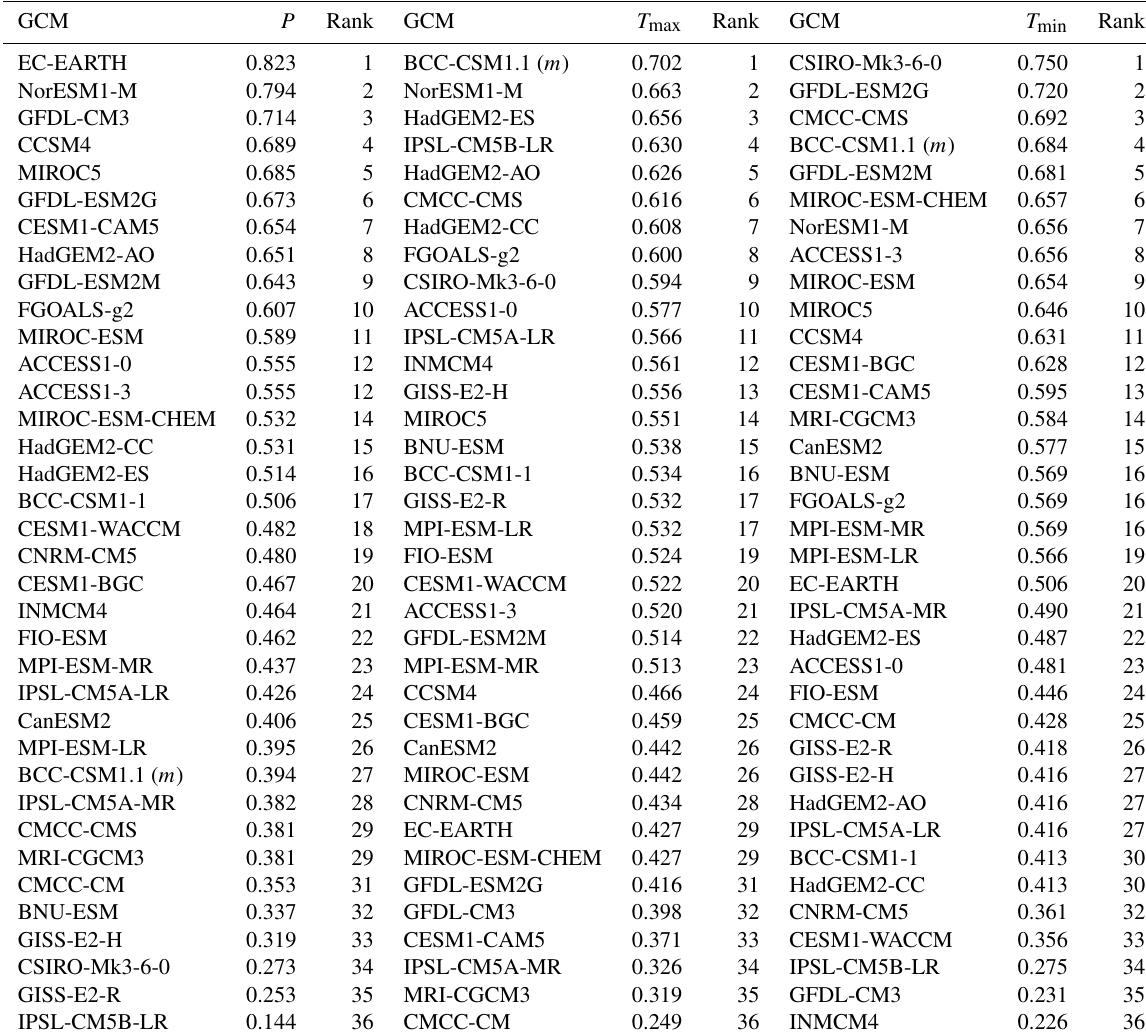
Table 4. Ranks of GCMs for P , T max , and T min based on rating metric values. GCM